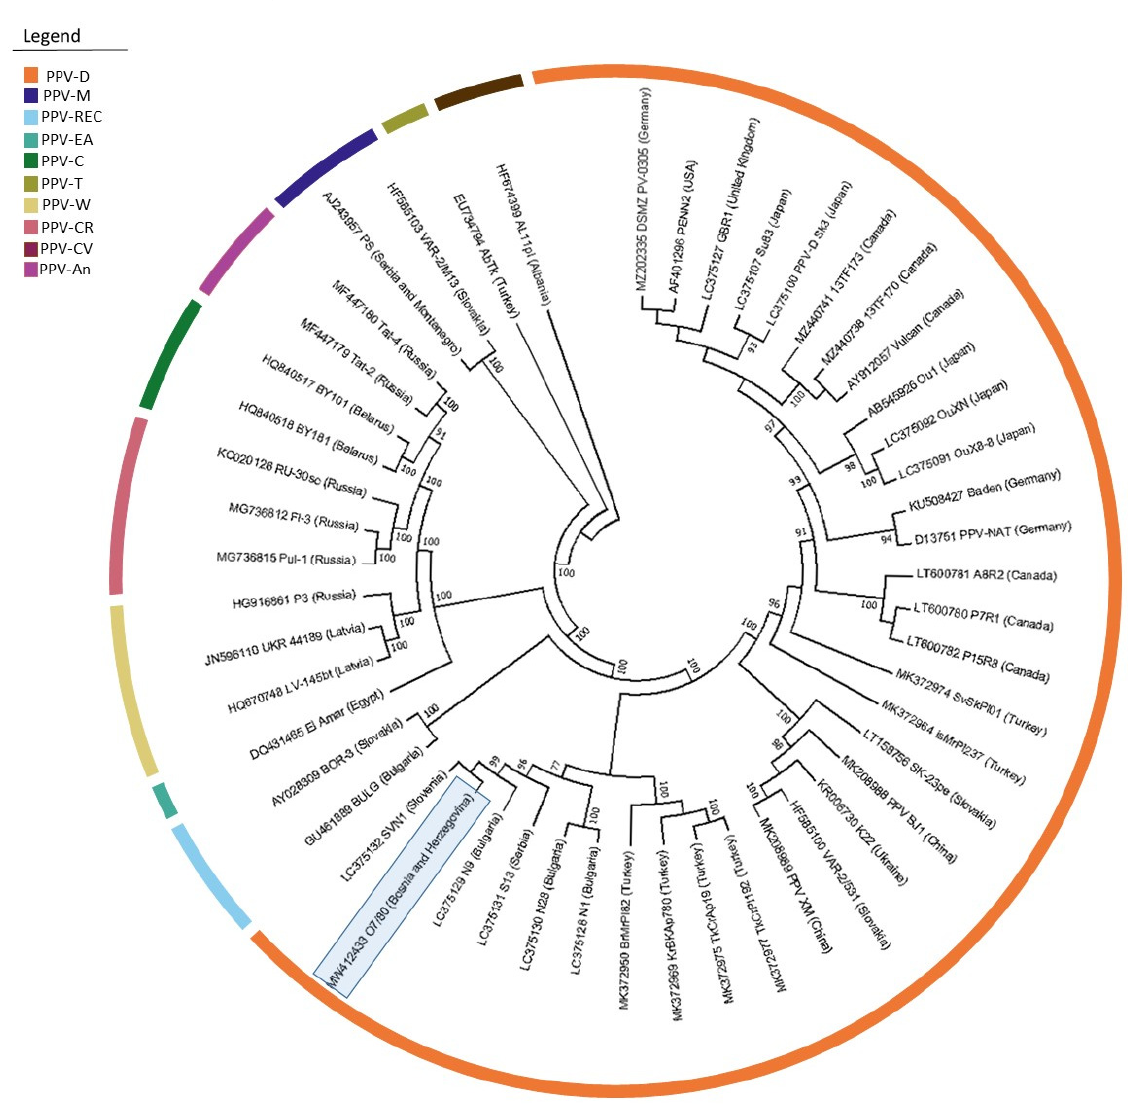
Figure 2. Maximum likelihood phylogenetic tree constructed from the complete genome sequences of PPV ‐ D. The isolate obtained in this study (PPV_O7/80; MW412433) is marked in a blue box and clustered in the PPV ‐ D group alongside isolates SVN1 (LC375132) from Slovenia. The tree was generated using the GTR+G+I model with 1000 bootstrap replications and rooted on the ancestor isolate (HF674399). Bootstrap values of 75% or more (out of 1000 replications) are indicated on the branches. Strains are color coded as shown in the